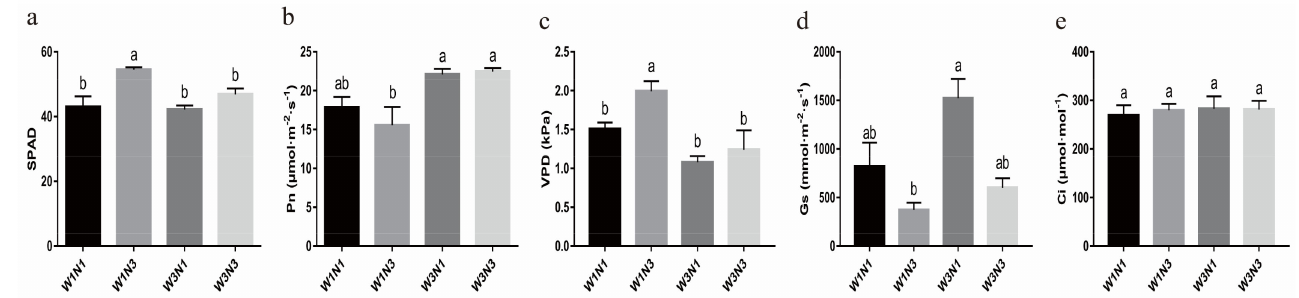
Figure 3. Leaf physiological characteristics associated with photosynthesis. ( a – e ) The relative chlorophyll content ( a ), net photosynthetic rate ( b ), saturated vapor pressure difference ( c ), stomatal conductance ( d ), and intercellular CO 2 concentration ( e ) of each treatment group. Values on bar are mean ± standard error ( n = 9). Different letters indicate significant differences ( p <